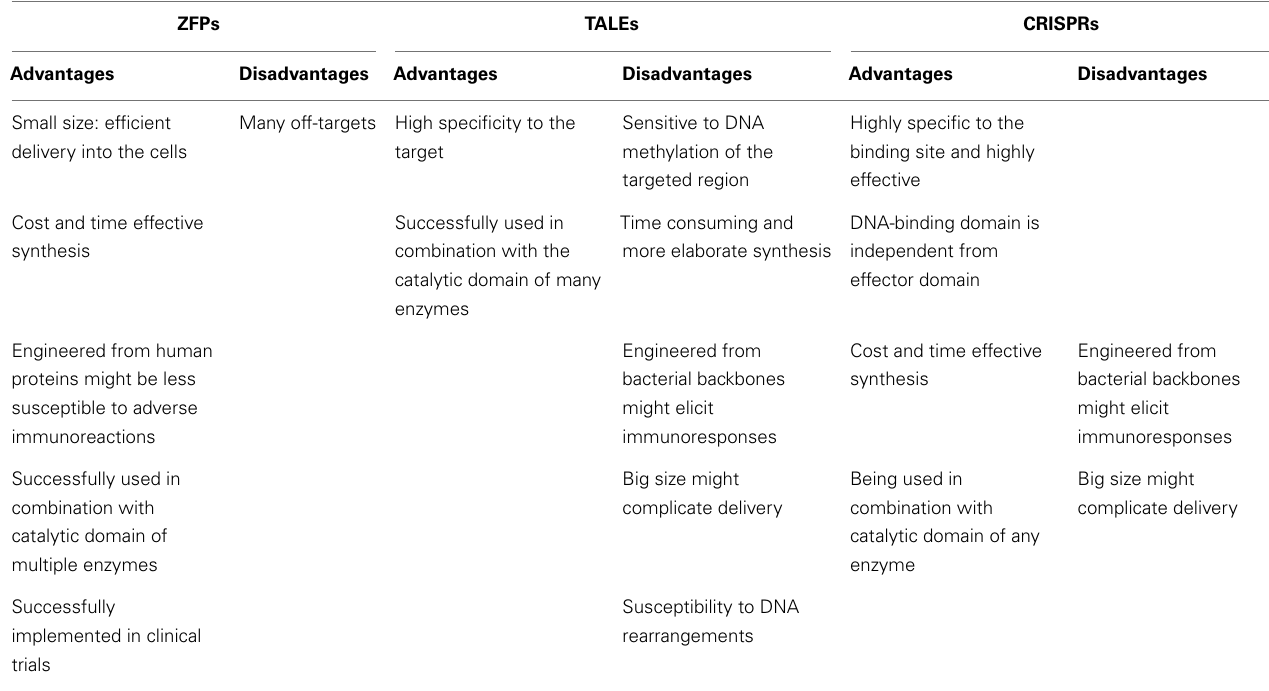
Table 1 | Comparison of DNA-binding backbones for genome engineering